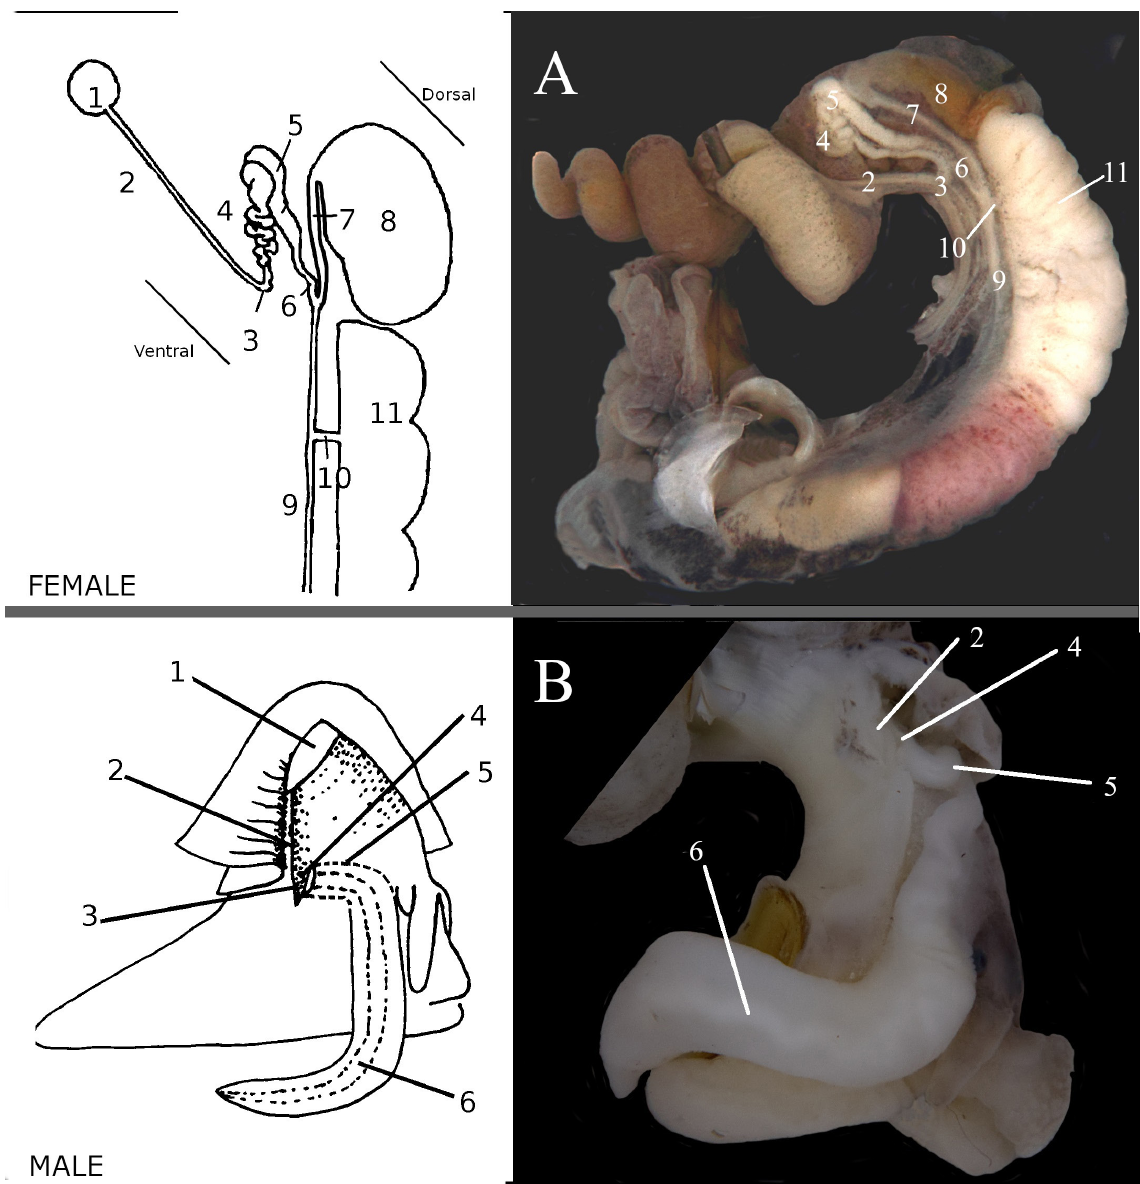
Fig. 5. Genitalia in Clessiniella Zallot et al ., 2015. A . Female genitalia ( Cochlostoma ( Clessiniella ) tergestinum (Westerlund, 1878) (WdM6998)). 1 = ovary; 2 = visceral oviduct; 3 = proximal loop; 4 = loops of the visceral oviduct; 5 = seminal receptacle; 6 = distal oviduct; 7 = pedunculus of the bursa copulatrix; 8 = bursa copulatrix; 9 = copulatory duct; 10 = channel of the uterine gland; 11 = uterine gland. B . Male genitalia ( Co. ( Cl. ) tergestinum (WdM7012)). 1 = anus; 2 = fold delimiting the sperm groove; 3 = sperm pocket; 4 = penial funnel; 5 = body spermiduct; 6 = penis with the internal